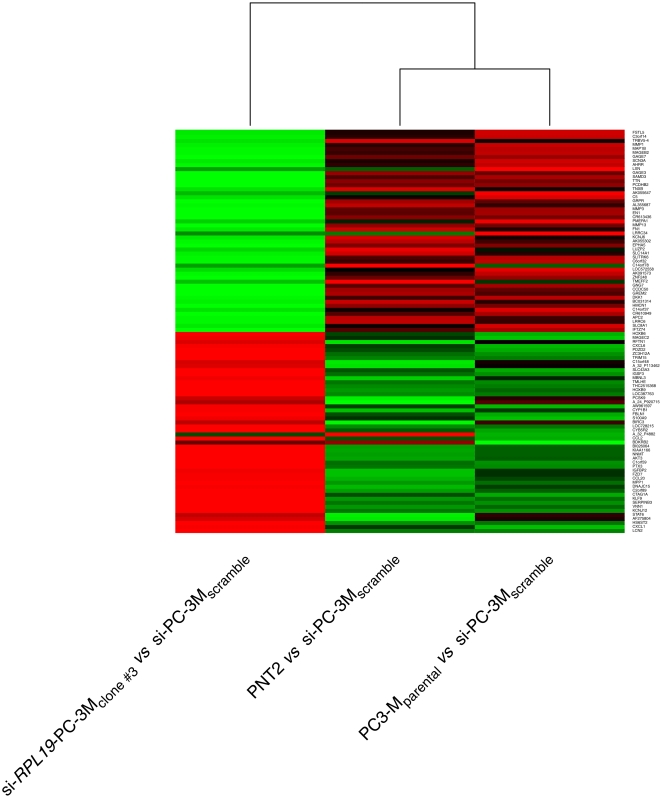
Graphical representation of gene expression modulated following RPL19 knockdown.Heat map of top 50 genes up-regulated and top50 genes down-regulated following expression-profiling of mRNA expressed by si-RPL19-PC-3Mclone ST-3 cells when compared to PC-3Mparental cells using PC-3Mscramble cells as the common denominator. Hierarchical clustering is shown. Green indicates genes over-expressed in a sample compared to scramble-transfected cells. Red indicates genes down-regulated in the sample when compared to scramble-transfected cells. Corresponding numerical data are presented in Supporting Information Tables S1 & S2.